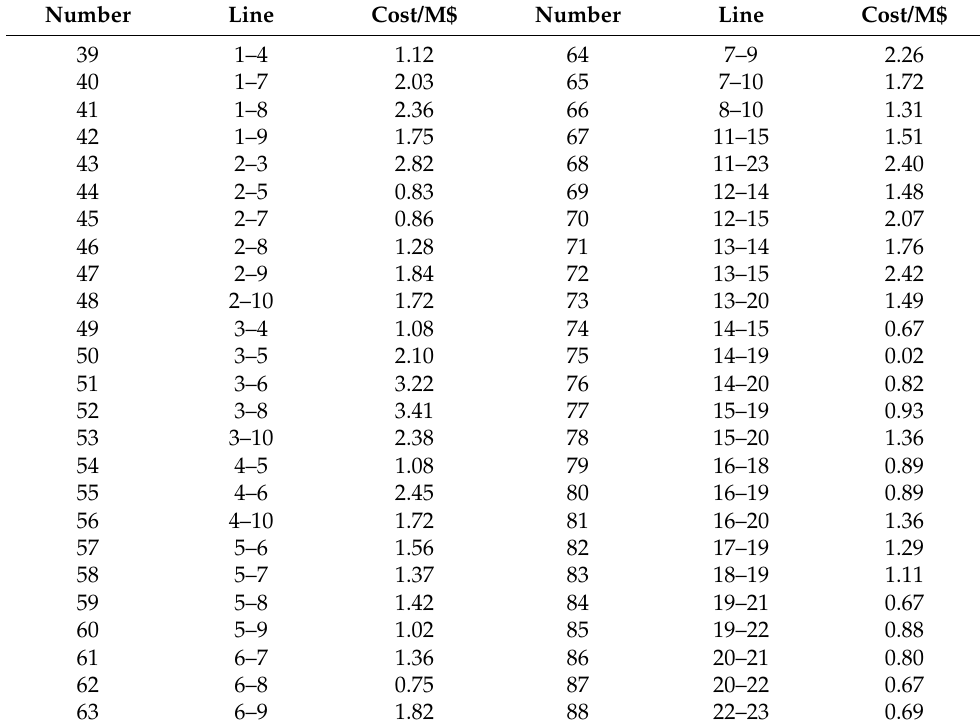
Table A1. The parameters of the 50 to-be-selected